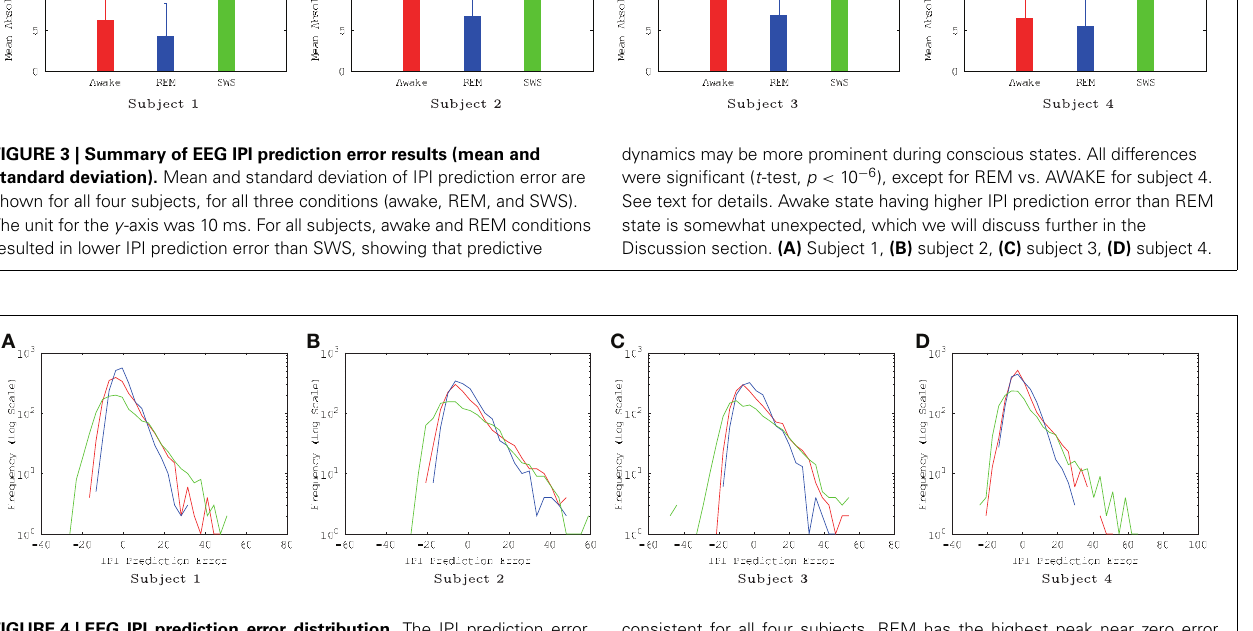
consistent for all four subjects. REM has the highest peak near zero error, closely followed by awake state, and finally SWS which shows the lowest peak. SWS has the heaviest tail, meaning that high error values are much more common than awake state or REM. (A) Subject 1, (B) subject 2, (C) subject 3, (D) subject 4.